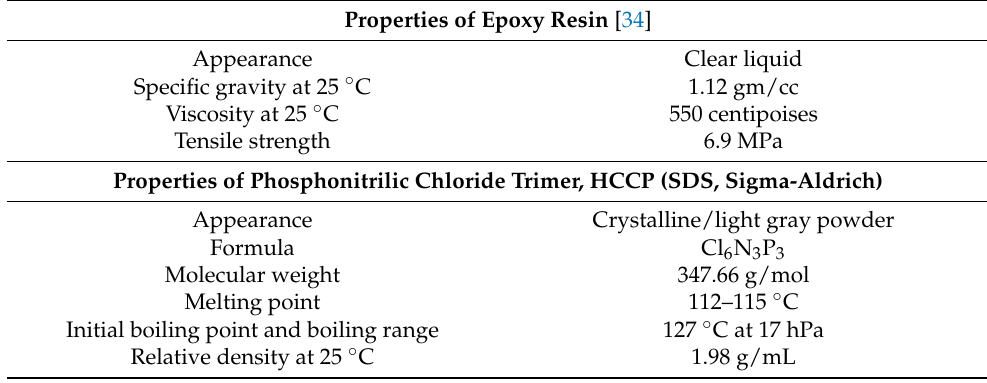
Table 1. Typical properties of epoxy resin and